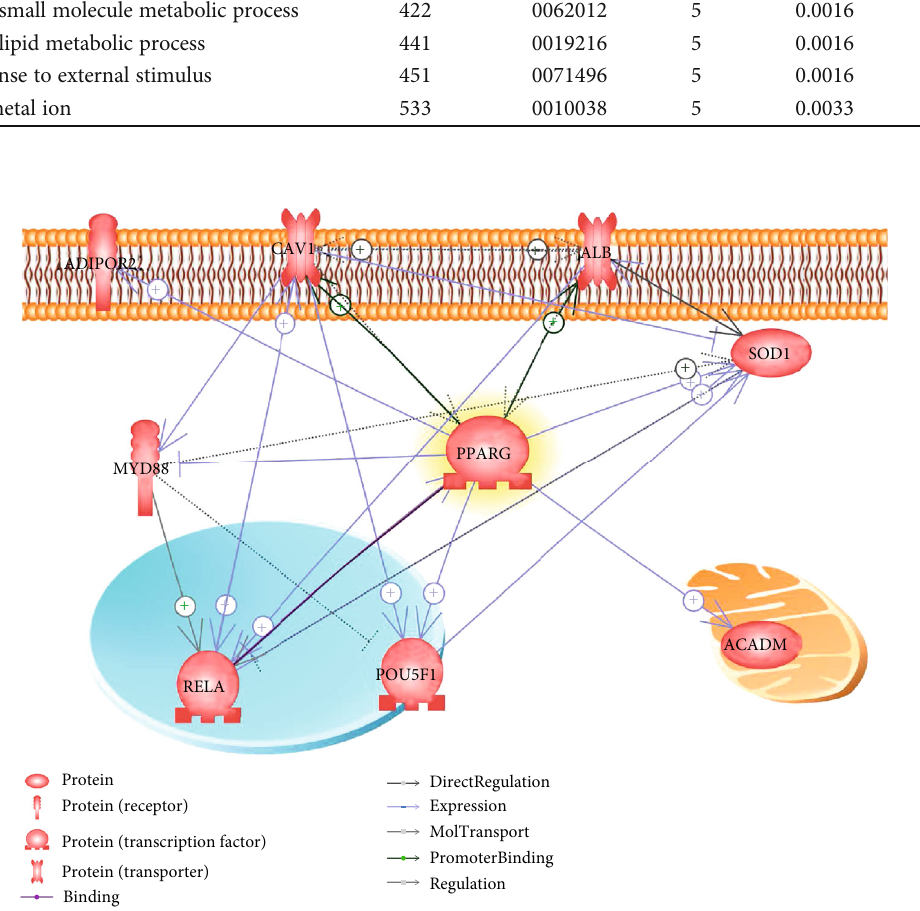
Figure 2: Protein-protein connection networks among the eight genes involved in PPARG-MI signaling pathways. The network was built using Pathway Studio (http://www.pathwaystudio.com). One or more references supported each relationship within the network. + represents positive regulation; -| is